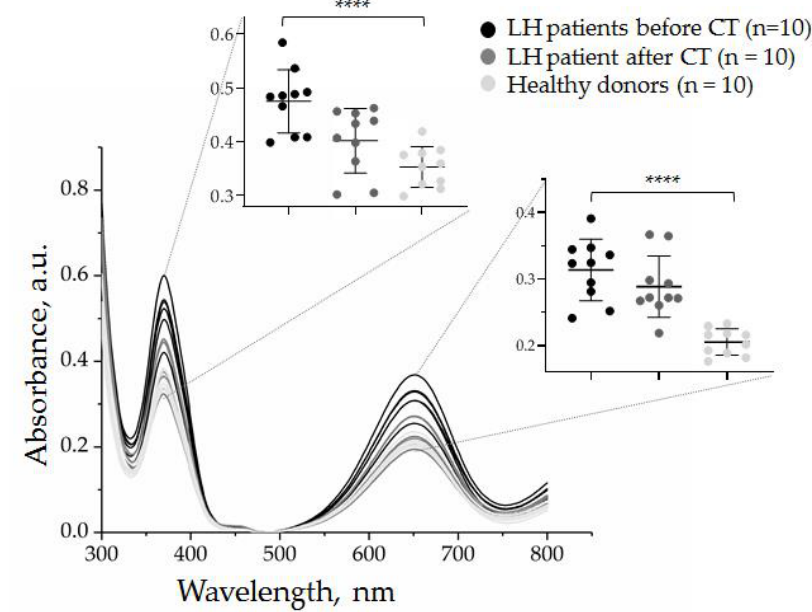
Figure 11. Evaluation of the effect of two cycles of chemotherapy on the quantity of CD30 + SEVs in the plasma of cHL patients by the AuNP aptasensor with the CD30 aptamer. The results of the analysis of ten samples of healthy donors are included for comparison. The results of the absorbance measurements at 370 and 652 nm are presented in inserts. The statistical significance of the observed difference was evaluated with the nonparametric Kruskal–Wallis test (**** p < 0.00005).